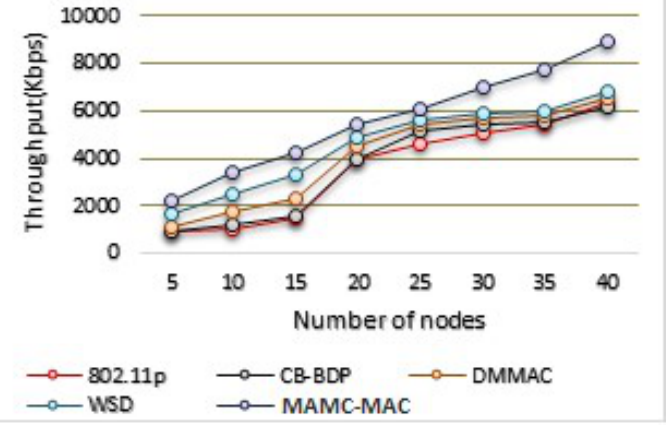
Figure 7. Throughput comparison.